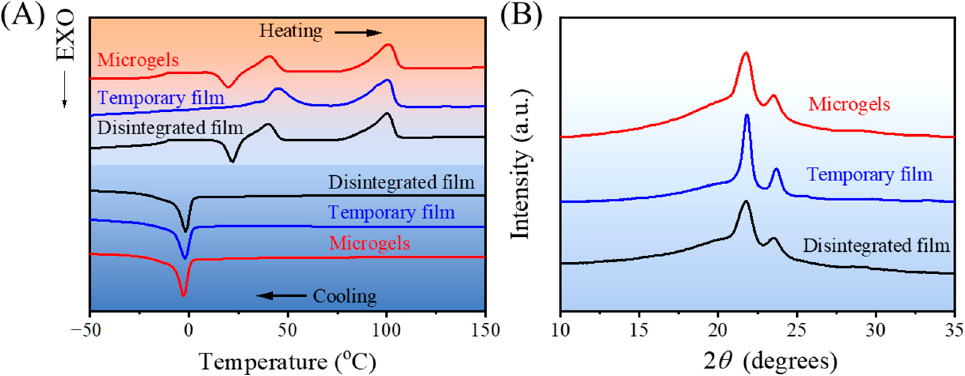
Figure 4. DSC curves ( A ) and XRD patterns ( B ) of microgels, the temporary film, and the disinte- grated film.